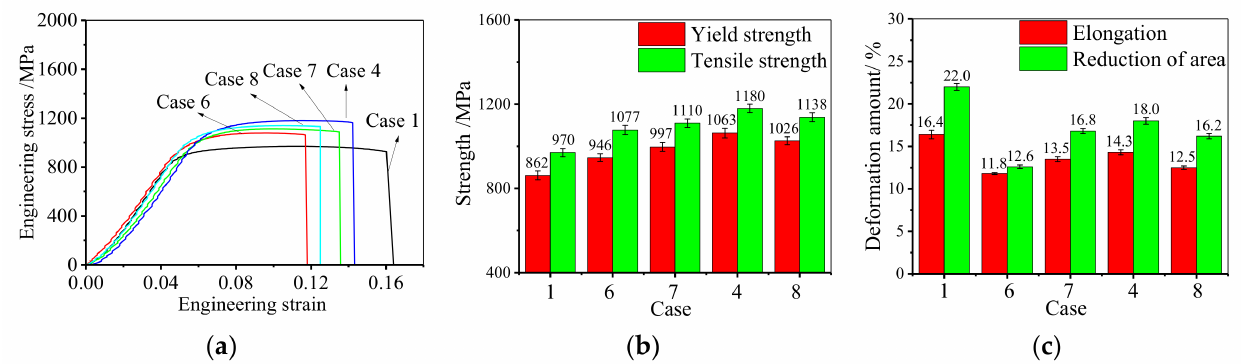
Figure 5. Effect of SSA time on high-temperature tensile behavior: ( a ) engineering stress–engineering strain curve; ( b ) strength; ( c ) elongation to